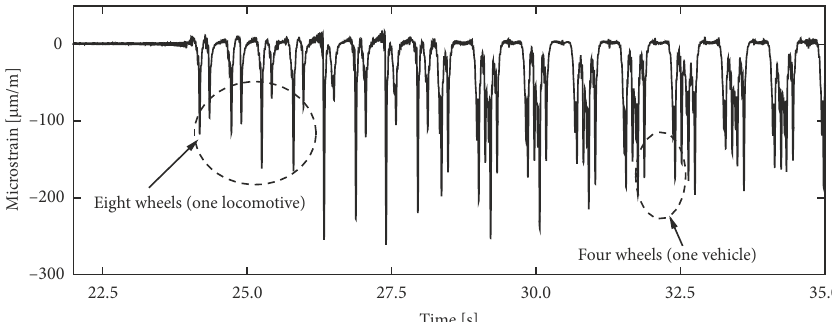
Figure 7. Microstrain signal representing the wheel–rail vertical dynamic forces